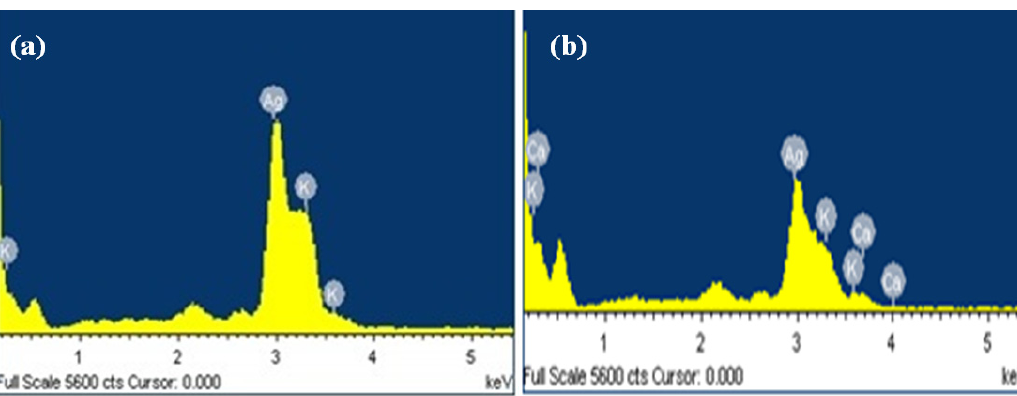
Fig. 4. Energy Dispersive X-ray Spectroscopy images of synthesized AgNPs for L.glutinosa. a) Leaf and b) Stem